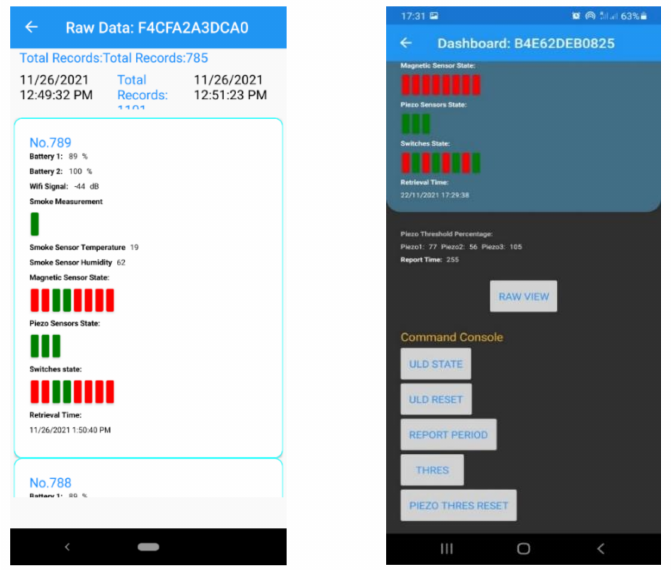
Figure 6. ULD sensor data report as presented in the HMI application ( left ). ULD dashboard screen, where the user can change parameters regarding data acquisition from its sensors ( right